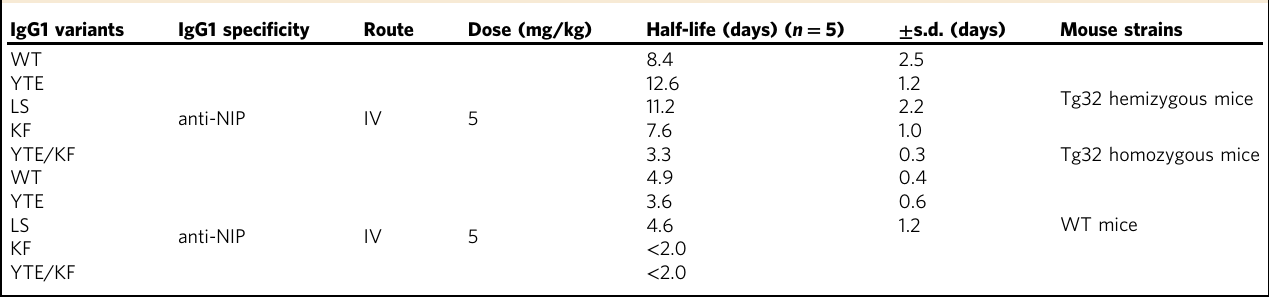
Table 2 Serum half-life data in WT and humanized FcRn mice IgG1